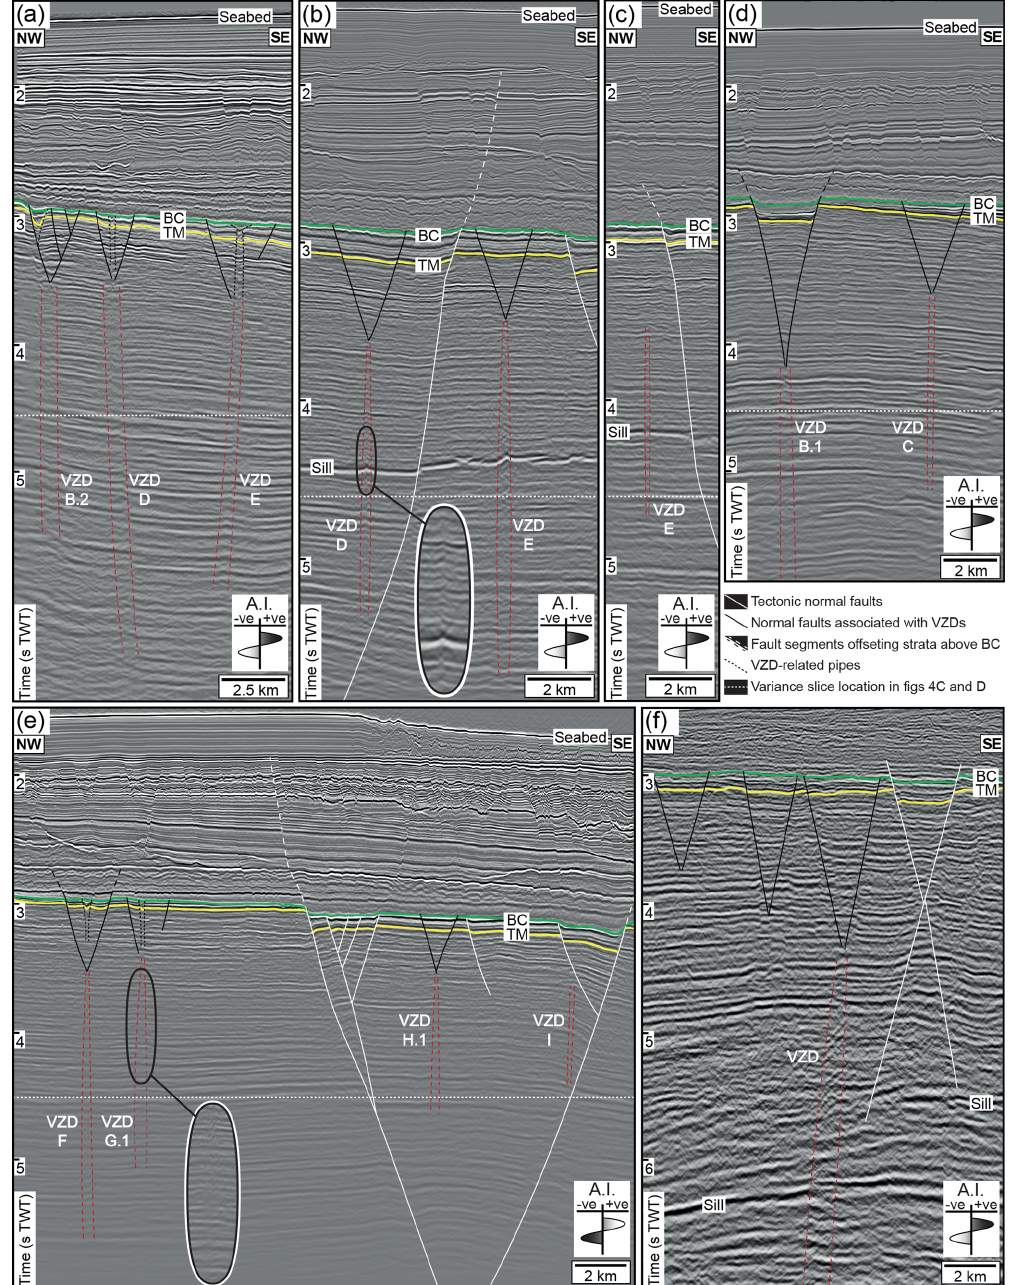
Figure 6. (a–f) Interpreted seismic sections from different surveys demonstrating the variations in VZD expression. The near Top Mungaroo horizon (TM) and near Base Cretaceous unconformity (BC) are shown. Normal fault-bounding grabens, which occasionally contain pipe-like features, occur directly above and converge on VZD upper tips; these VZD-related faults are shorter and accommodate less throw relative to larger tectonic faults. For clarity, fault displacement arrows are omitted. See Fig. 4d for line locations. See Fig. S5 for uninterpreted